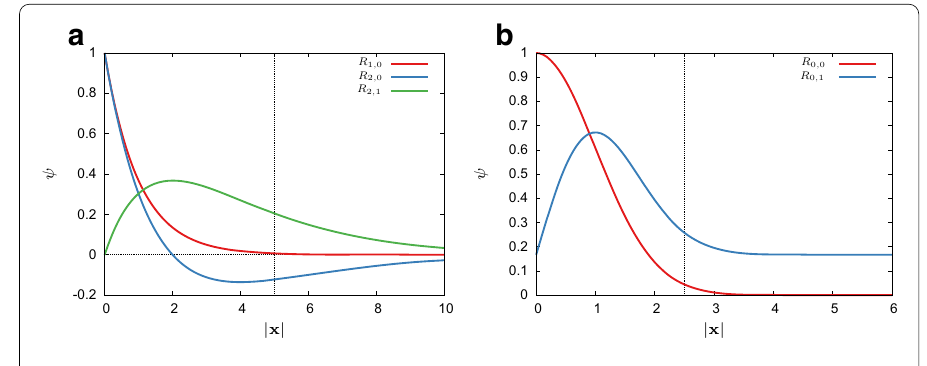
Fig. 1 Radial components of eigenfunctions for different potentials V ( x ). The dotted vertical line indicates the smallest initial mesh size which will be used in our numerical calculations. a Coulomb. b Harmonic